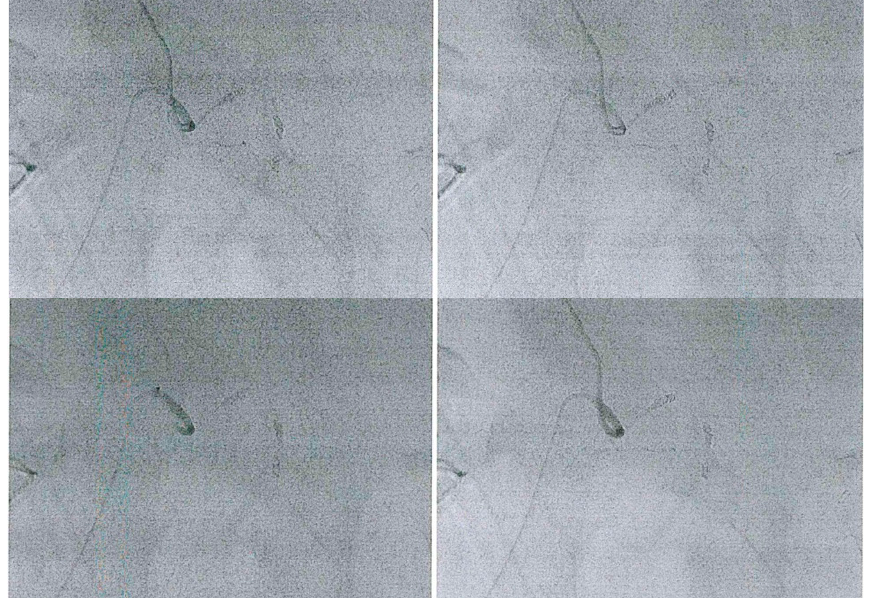
Figure 4. Angioembolization is performed using four metallic microspirals Nester ® Cook 3 × 2 mm.